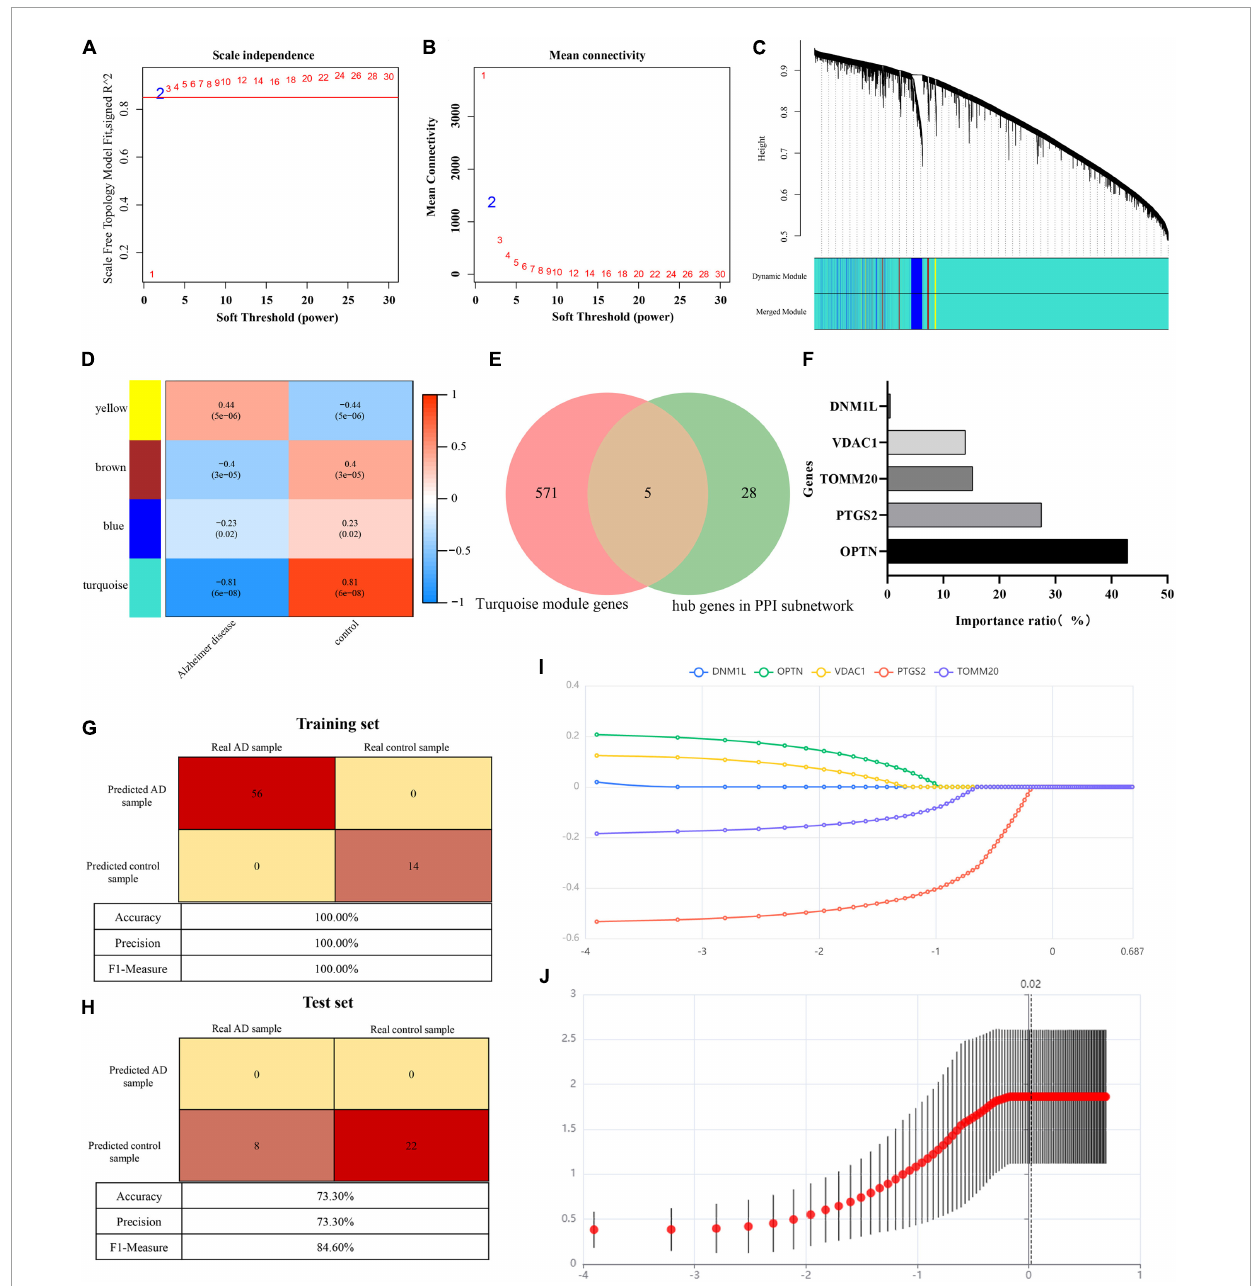
FIGURE5 (A) Scale-free co-expression network. (B) Soft threshold and average connectivity value. (C) Dendrogram of all differentially expressed genes clustered. (D) Correlations between modules and phenotypes. (E) Venn showing common genes between turquoise module genes and hub genes in PPI subnetwork. (F) Histogram shows the proportion of importance of random forest features (independent variables). (G) Confusion matrix heat map shows the classification results of training sets in GSE122063 by random forest classifier. (H) Confusion matrix heat map shows